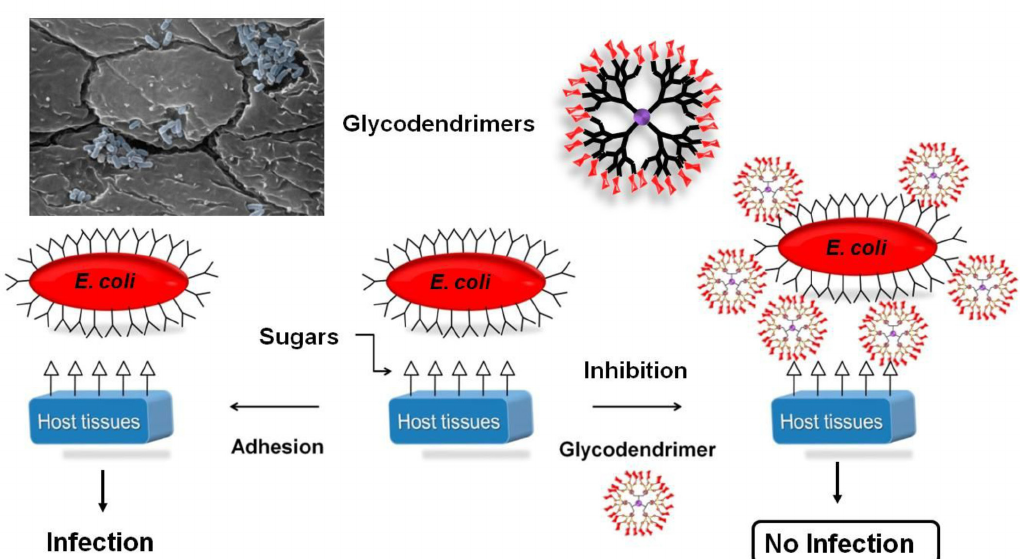
FIGURE 13 - Glycodendrimer inhibition strategy to block bacterial adhesion to host tissues. Given the usual low affinity of monovalent carbohydrate ligands toward bacterial lectins, multivalent ligand presentation on dendritic scaffolds leads to more potent